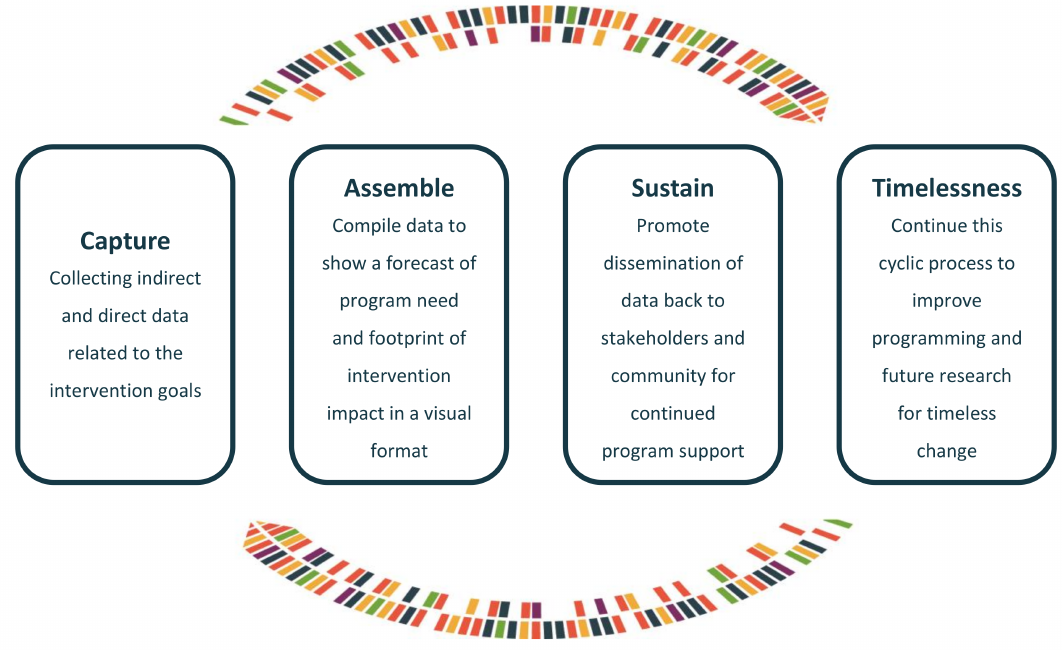
Figure 1. eB4CAST framework